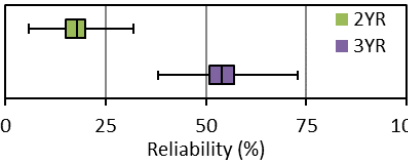
Figure 6. Box–whisker plots of the reliabilities of the 3YR (33000ha) and 2YR (50000ha) systems for typical values of in- take ratio (IR) and irrigation efficiency (IE).